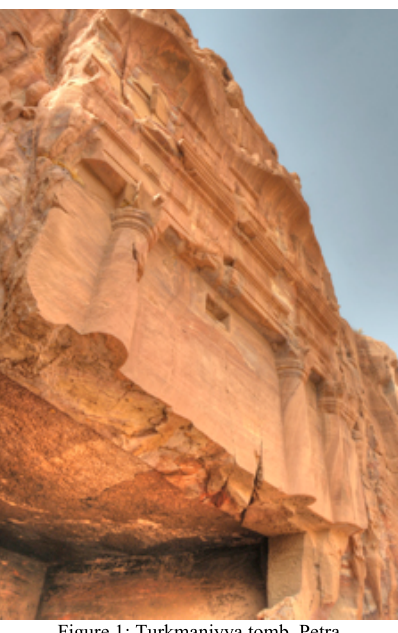
Figure 1: Turkmaniyya tomb,